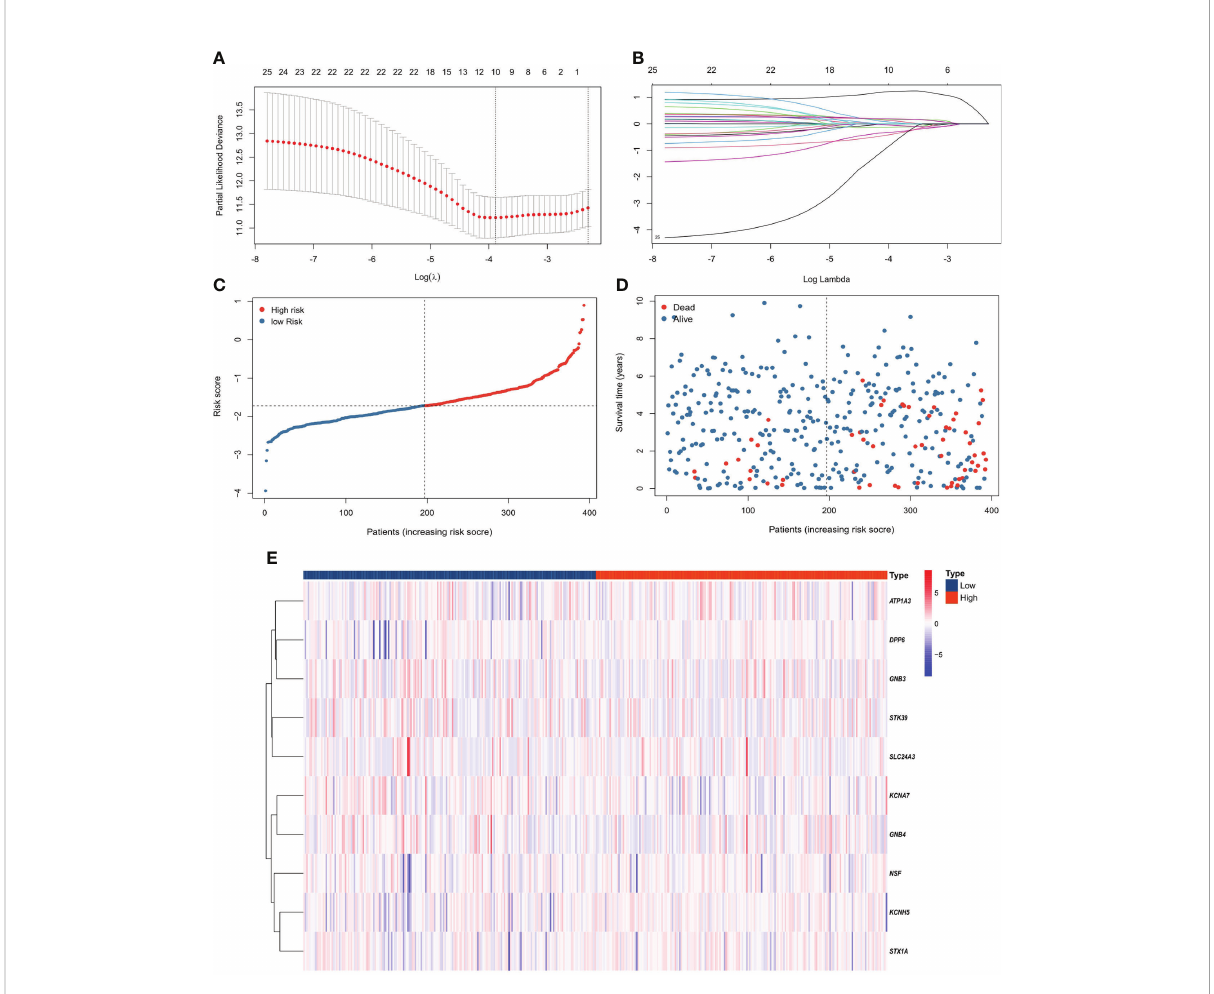
FIGURE 2 Construction of the PCRG prognostic signature. (A) Selection of the optimal parameter ( l ) of LASSO regression through cross-validation. (B) LASSO coef fi cient pro fi les of the 10 genes that comprise the prognostic signature selected by l . (C) The TCGA-KIRC cohort was divided into high-risk and low-risk groups according to the median risk score value. (D) Higher mortality was observed in the high-risk group than in the low-risk group. (E) Heatmap of the expression levels of 10 PCRGs in the high-risk and low-risk groups.